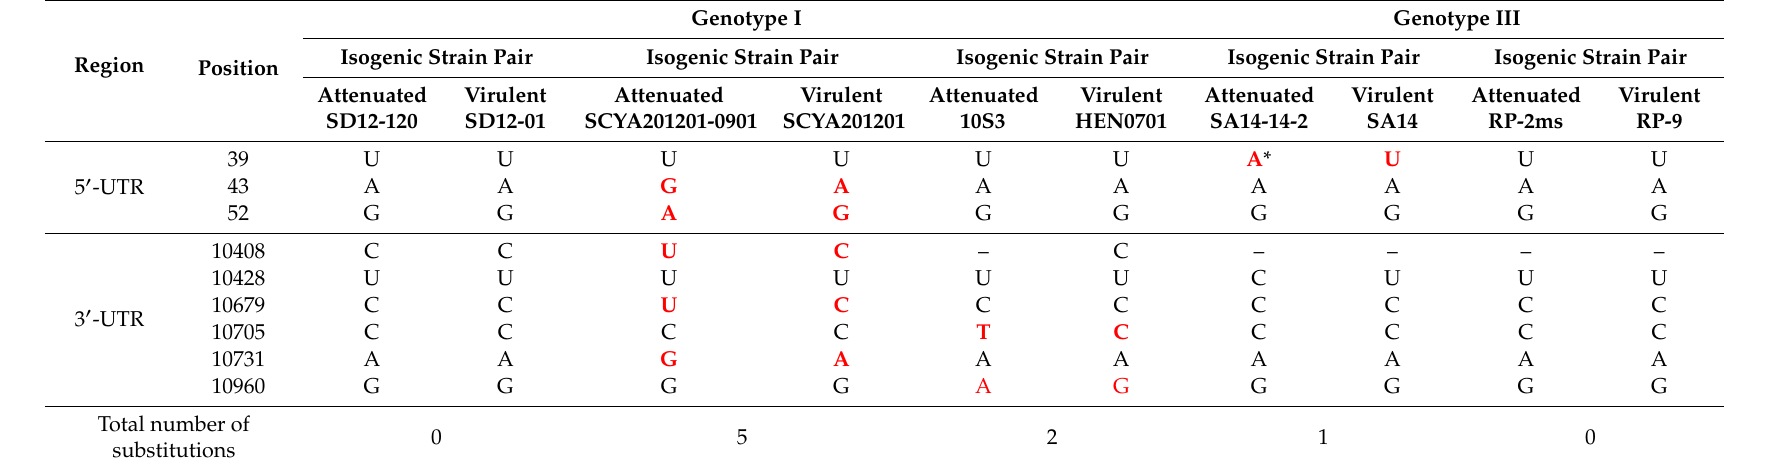
Table 4. Nucleotide variations in the UTR regions between attenuated and virulent